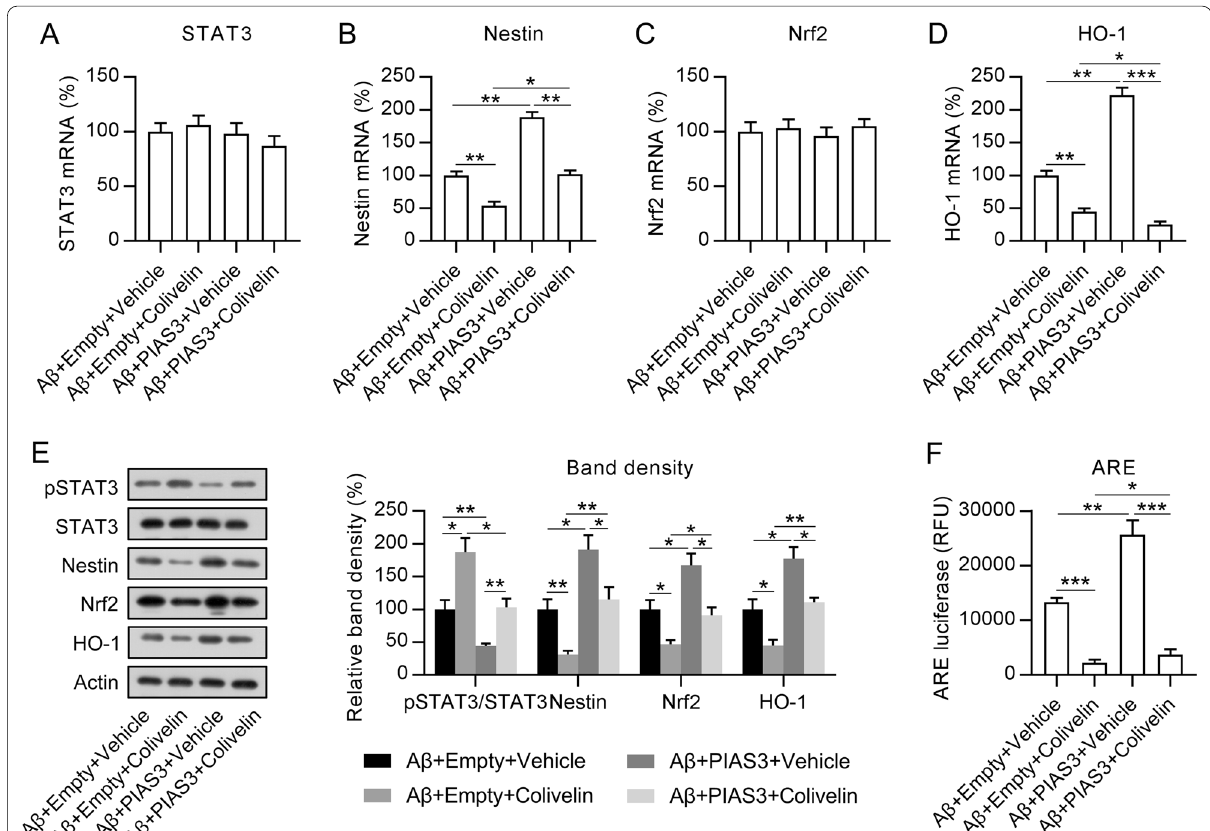
Fig. 6 Effects of colivelin treatment on STAT3 activation and Nestin/Nrf2/HO-1 pathway in Aβ-treated SH-SY5Y cells. Cells were subjected to transfection with a PIAS3 overexpression vector or an empty vector for 1 d, and subsequently subjected to Aβ treatment (20 μM in 0.1% DMSO) and colivelin treatment (0.5 μM in 0.1% DMSO) for an additional 1 d. A – D qPCR was used to determine mRNA level expressions of STAT3, Nestin, Nrf2, and HO-1. E WB was utilized for determining protein level expressions of STAT3, Nestin, Nrf2, and HO-1, and STAT3 phosphorylation in SH-SY5Y cells. F ARE luciferase activity was also determined. Data represent mean SEM. **p < 0.01, ***p < 0.001. PIAS3, protein inhibitor of activated STAT3, ± STAT3 signal transducer and activator of transcription 3, Nrf2 nuclear factor erythroid 2-related factor, HO-1 heme oxygenase-1, qPCR